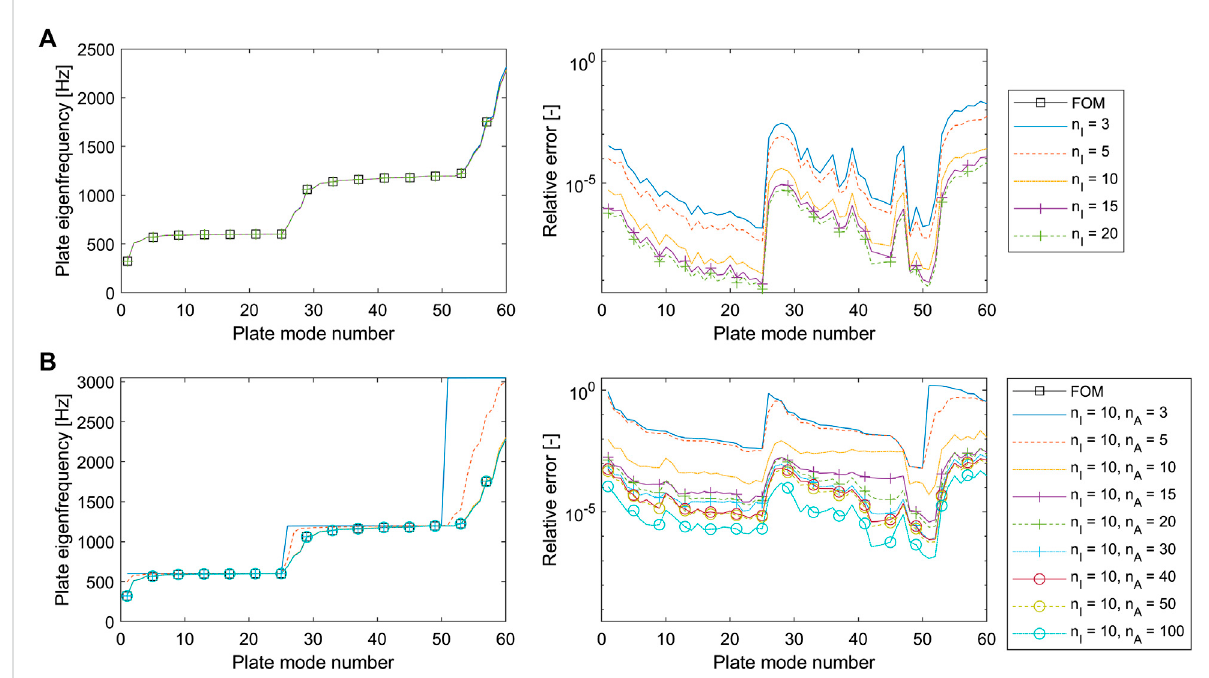
FIGURE 3 (A) Eigenfrequencies (left) and relative error of the eigenfrequencies (right) computed for the clamped fi nite plate assembly of 5 × 5 BMS UC ROMs, considering different n ϕ I . (B) Eigenfrequencies (left) and relative error of the eigenfrequencies (right) computed for the clamped fi nite plate assembly of 5 × 5 GBMS UC ROMs, considering n ϕ I (cid:2) 10 and different n ϕ A